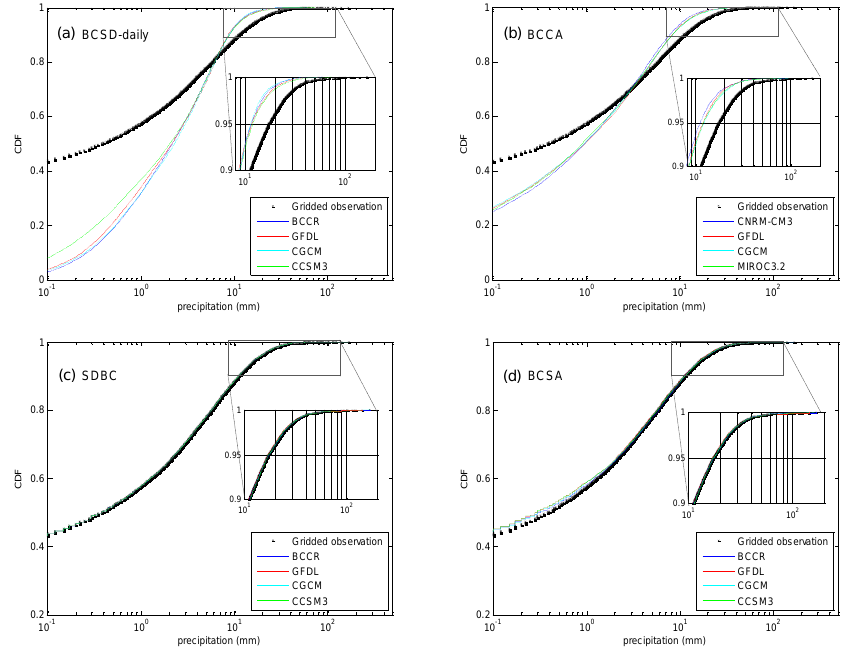
Fig. 10. Comparisons of CDFs for daily precipitation predictions from 4 GCMs downscaled using (a) BCSD_daily, (b) BCCA, (c) SDBC, and (d) BCSA and observed CDF for an example grid cell located in west central Florida.